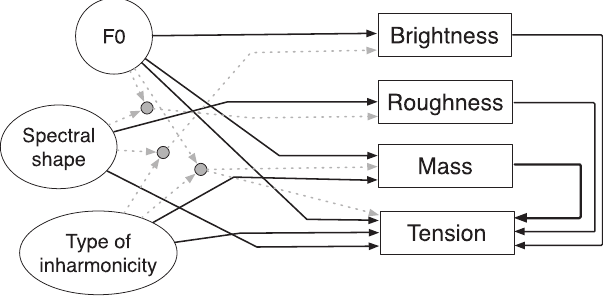
Figure 6. The web of relationships between the four qualities and the acoustical conditions of this experiment in the general context of continuous inharmonicity alteration. Black lines indicate a main effect and dashed grey lines indicate an interaction effect. F 0 was the most in fl uential acoustic parameter for predicting the variation of the qualities under study followed by inharmonicity type and spectral shape. Finally, as shown on the right, mass was the best predictor of tension but brightness and roughness also had a signi fi cant effect.